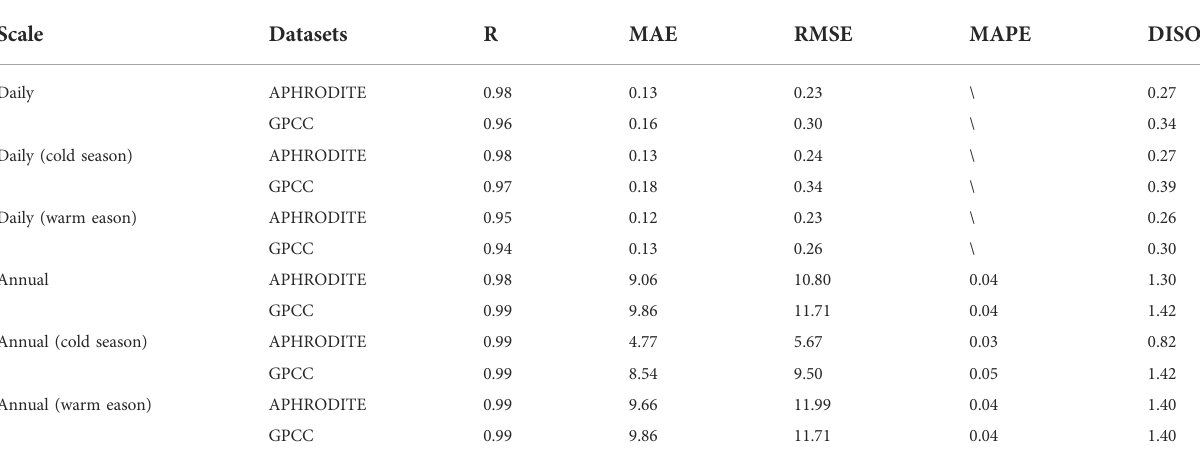
TABLE 2 The statistical metrics and DISO index of gridded